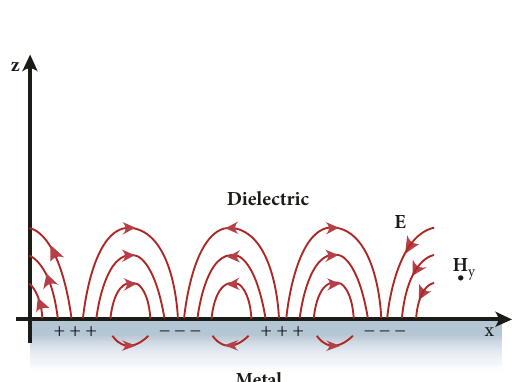
Figure 2: Schematic diagram of LSPs [19].